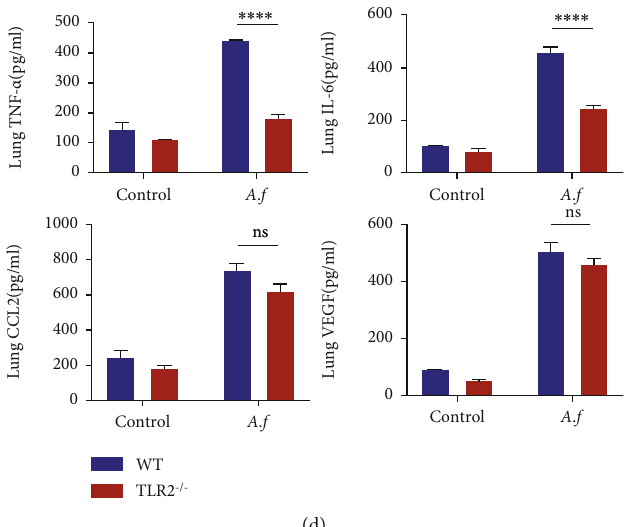
Figure 3: C57BL/6 mice and TLR2 − / − mice were infected with A. fumigatus spores and monitored for 3 days. (a) The expression of TLR2 protein in the lungs of mice which was infected with A. fumigatus for 3 days was detected by Western blot and analyzed by imager systems described in Section 2, and the mRNA levels of TLR2 were determined by q-PCR ( n = 3 /group). (b) Fungal load (colony-forming unit) after 3 days of infection ( n = 5 /group). (c) H&E staining of the lung tissues of A. fumigatus -infected WT mice and TLR2 − / − mice at 100x and 400x magni fi cation, mainly in fi ltration of macrophages and monocytes in the lungs of TLR2 − / − mice with A. fumigatus , with alveolar congestion and hemorrhage. TLR2 − / − mice su ff ered from interstitial congestion and hemorrhage less obviously after A. fumigatus infection than WT mice. ( n = 5 /group). (d) TNF- α , IL-6, CCL2, and VEGF expression levels in the lung of mice were detected by ELISA. TLR2-de fi cient downregulated the production of proin fl ammatory cytokines/chemokines in lung tissues treated by A. fumigatus , including TNF- α , IL-6, CCL2, and VEGF ( n = 3 /group). Experiments were done at least three times. ns: not signi fi cant; ∗ p < 0 : 05 , ∗∗ p < 0 : 01 , ∗∗∗ p < 0 : 001 , and ∗∗∗∗ p < 0 : 0001 by Student ’ s unpaired two-tailed t test and the two-way ANOVA followed by the Tukey post hoc test. Error bars represent